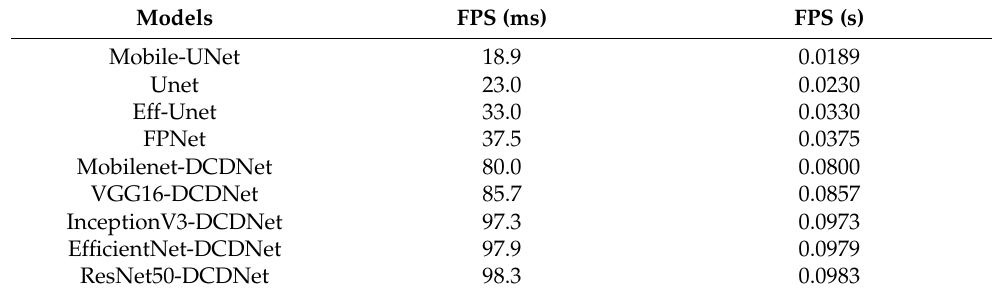
Table 6. Comparison of deep learning models in terms of time consumption (ms: milliseconds, s: seconds). Models FPS (ms) FPS (s) Mobile-UNet 18.9 0.0189 Unet 23.0 0.0230 33.0 0.0330 37.5